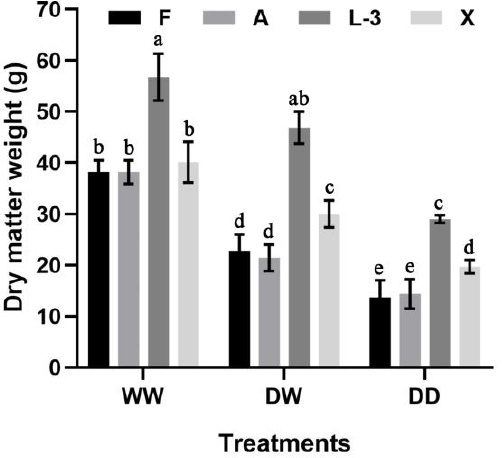
Figure 5. Dry matter weight of above-ground parts of four potato cultivars under different conditions. WW, irrigation condition. DW, half-irrigation condition. DD, drought condition. F, Favorita cultivar. L-3, Longshu No.3 cultivar. A, Atlantic cultivar. X, Xindaping cultivar. Each value is the average of three replicates, and error bars represent ± SD. Different letters (a–e) represent significant differences at p < 0.05 level.